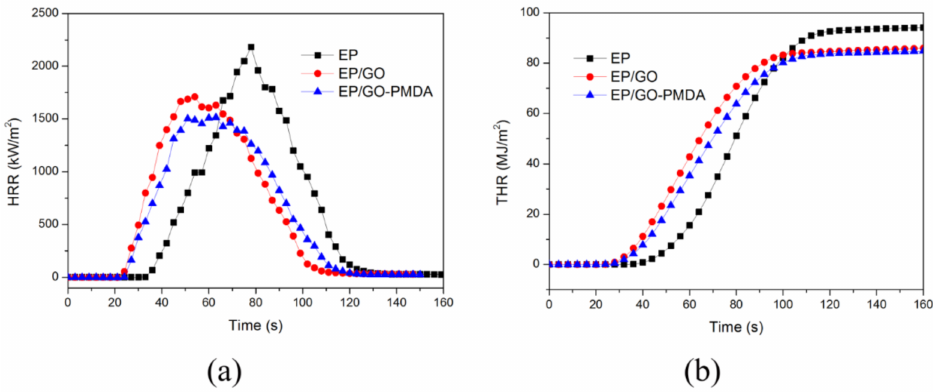
Figure 8. HRR ( a ) and THR ( b ) curves of EP, EP/GO, and